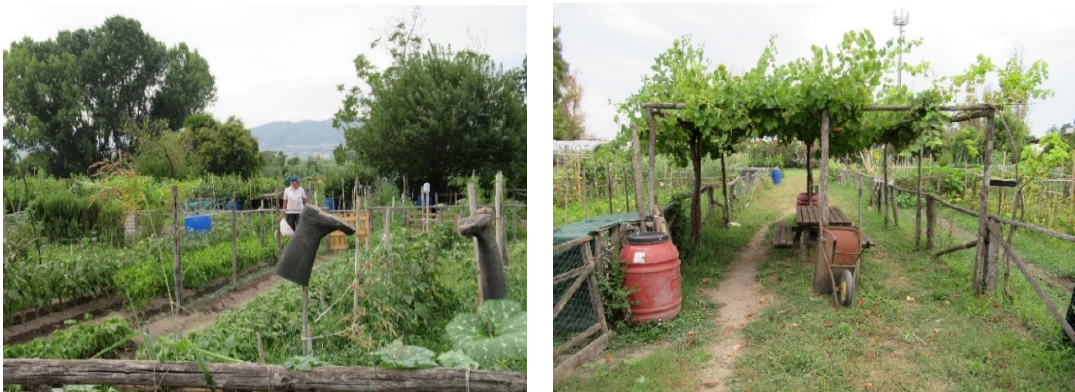
Figure 3. Urban agricultural and EGI integrated zoning within the archaeological ark in Pontecagnano, Salerno. Top left —park map; top right —entrance allotment garden; bottom left —allotment garden; bottom right —allotment garden socialization space. Source: Photographs taken by A. Russo on 16 July 2018.